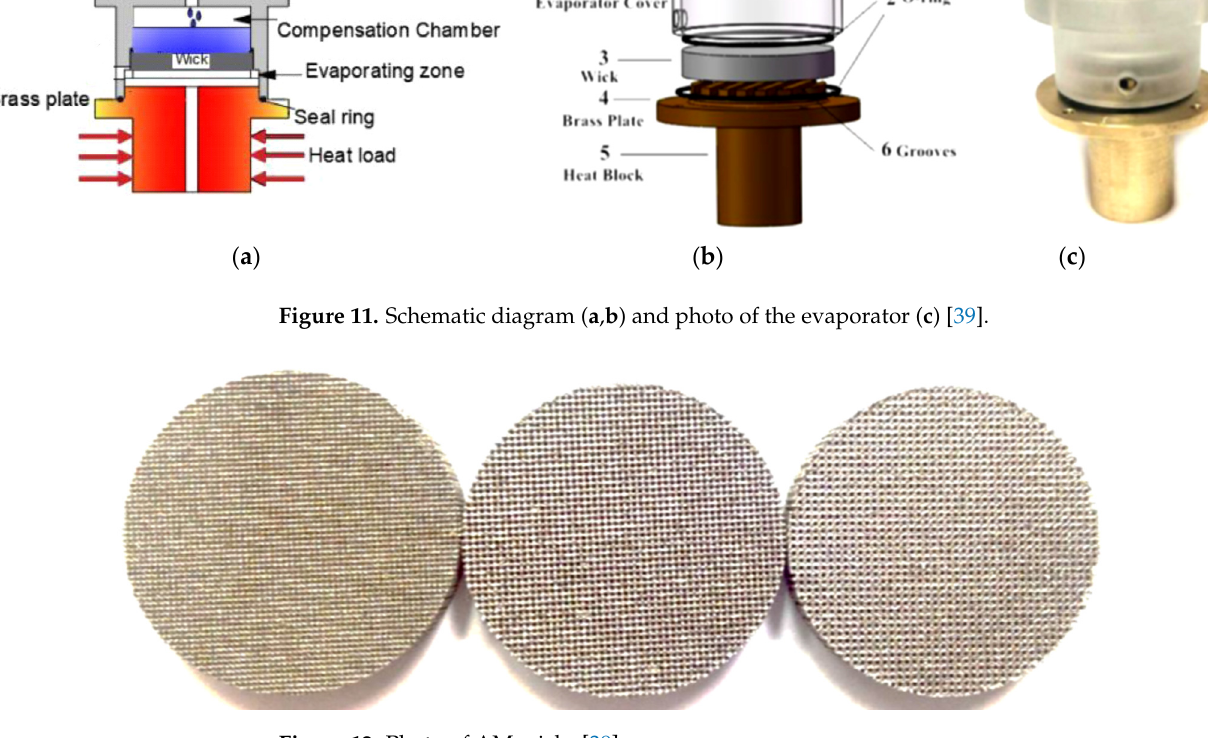
Figure 13. Titanium AM HP ( left ) and HP assembly ( right ) [17].